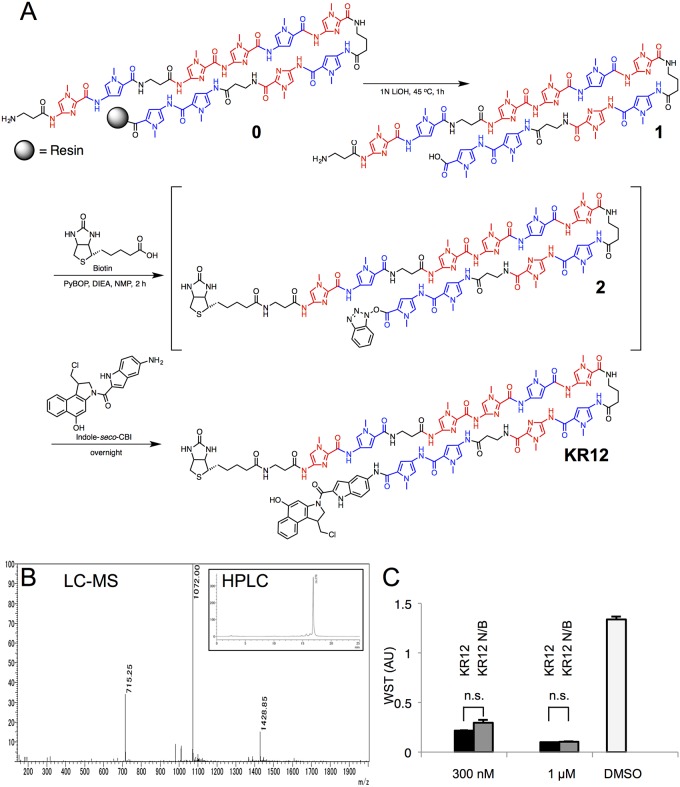
Next-generation sequencing with biotinylated KR12.(A) Synthetic scheme of KR12 from the non-biotinylated precursor KR12 N/B, with pyrroles and imidazoles colored in blue and red, respectively. (B) HPLC retention time diagram (upper right) and mass spectrum (LC-MS) of KR12. (C) WST assay of LS180 cells at 300 and 1000 nM dosage of KR12 (black) compared to the non-biotinylated precursor (KR12 N/B, gray) and DMSO only (white); error bars indicate ±1 SEM; n.s., no significance by two-sample Welch’s t-test.